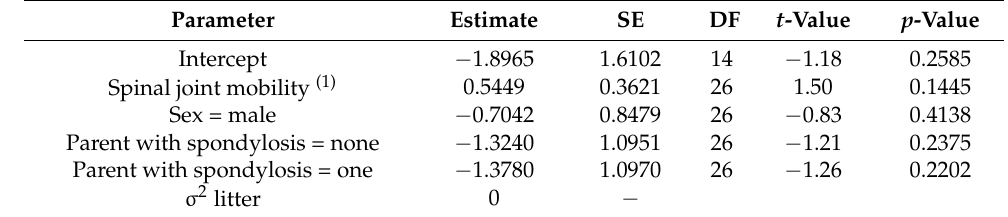
Table 3. Parameter values for model testing for the effect of the number of spinal joints with decreased mobility on spondylosis occurrence in one-year-old Boxers given repeated chiropractic treatment as puppies. The default settings (parameter estimate = 0) for the categorical fixed effect parameters are: sex = female and both parents having a score ≥ 1 according to the Norwegian scoring